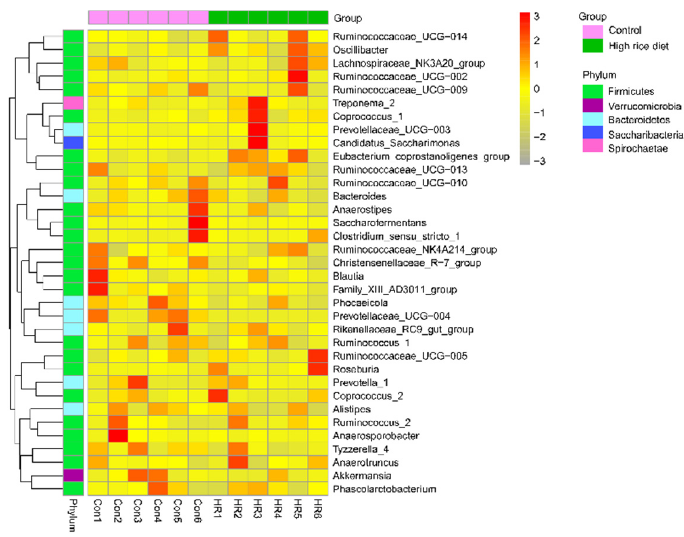
Figure 6. Heatmap based on the hierarchical clustering solution at the genus level (Bray–Curtis distance metric and complete clustering method) for goats fed a control diet or a high-rice diet, shown across columns.